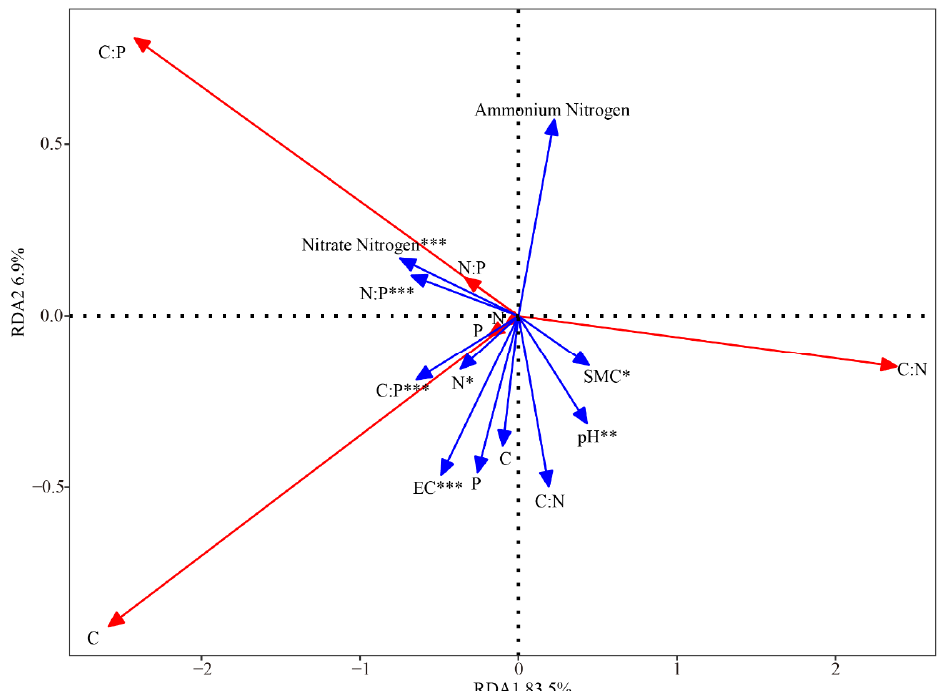
Table 3. Properties of underlying soil of moss crusts.